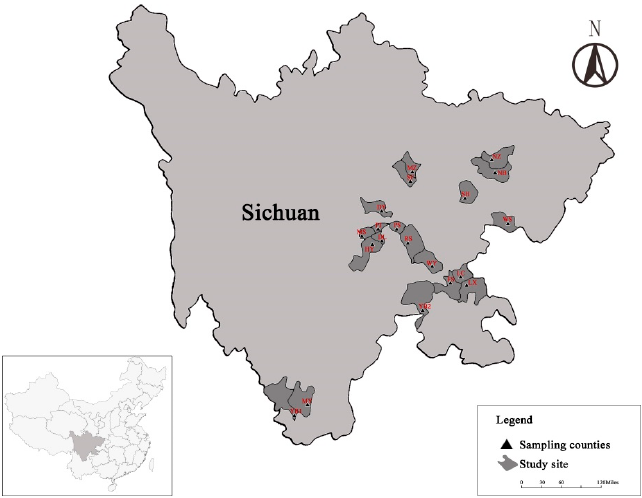
Figure 1. Location of the counties selected for sampling in Sichuan. Note: The sampling counties and their abbreviations are displayed in Table 1.